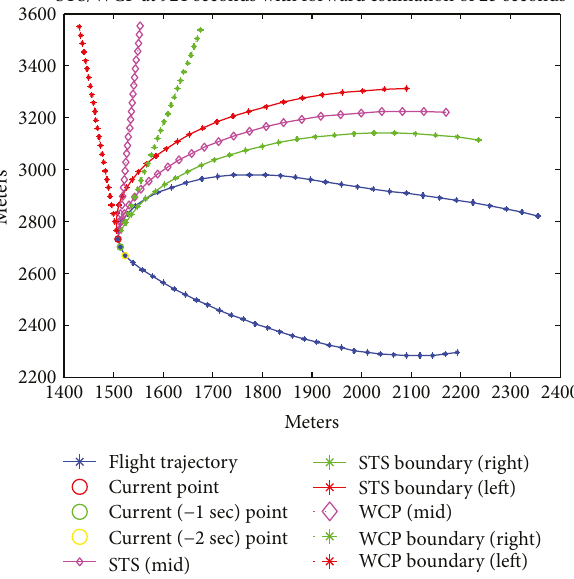
Figure 9: STS versus WCP fl ight estimation at 921 seconds.